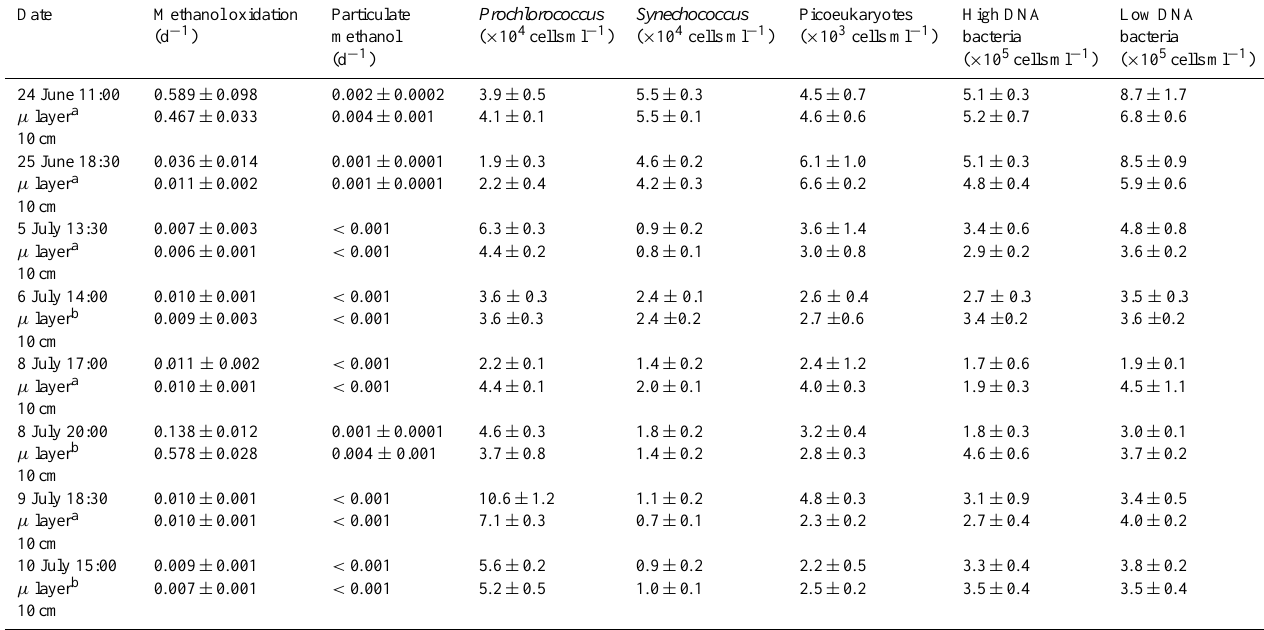
Table 1. Summary of methanol uptake and cellular abundance in the microlayer and 10cm-depth layer in the low chlorophyll a tracer (SF 6 ) patch area. Error bars are based on 2–6